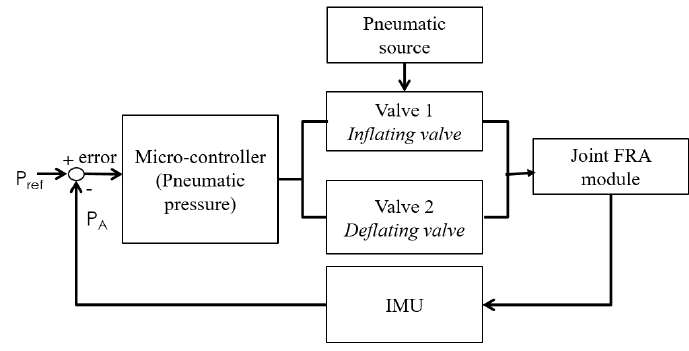
Figure 9. Position control of the module assembly.